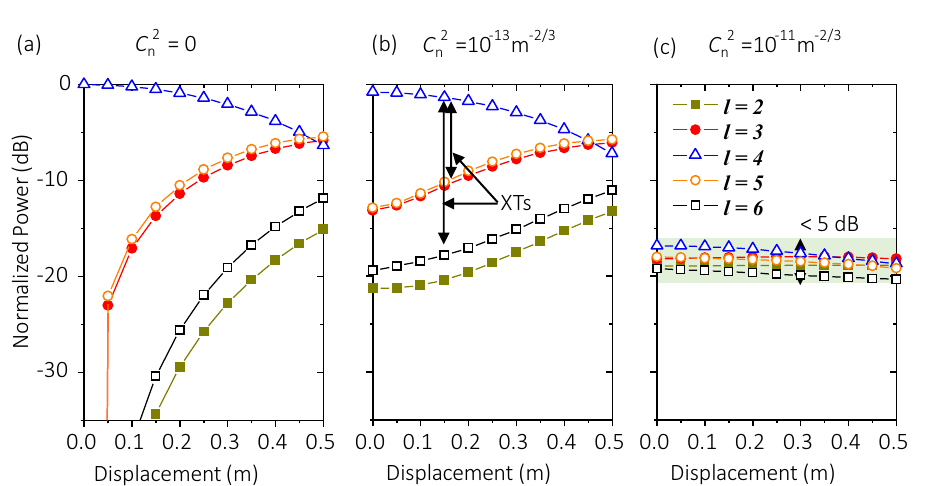
Figure 10. Effects of varying the displacement on the normalized power distribution on different OAM modes. 2 C 2 C 2 100-m links with ( a ) C n = 0 m −2/3 , ( b ) n = 1 × 10 –13 m −2/3 , and ( c ) n = 1 × 10 –11 m -2/3 . Other parameters are set as w 0 = 1 m, f = 5 THz, and OAM + 4 is transmitted. Legends and scales in y -axis in ( a – c ) are the same. XT